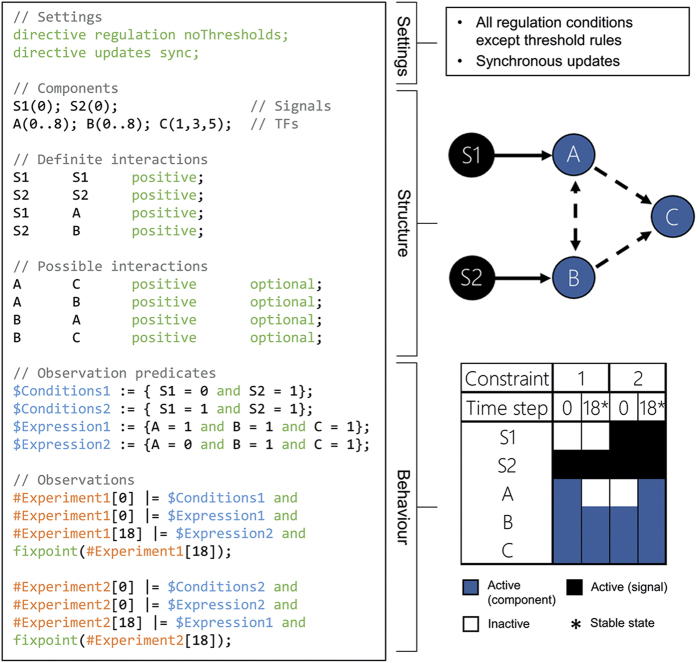
Encoding sets of models and constraints in RE:IN. Shown here is how to encode a set of components, regulation conditions, interactions and constraints in RE:IN, using the toy example from Figure 1 as an illustration. This highlights how to set assumptions, such as a synchronous update scheme, whether to include the Threshold regulation conditions, and how to restrict the set of regulation conditions for a specific components (e.g., C can only use conditions 1, 3, or 5). Constraints are defined as individual experiments, in which component states are defined (using labelled predicates, if desired) at specified time points. We also highlight how to define such a state to be a fixed point.